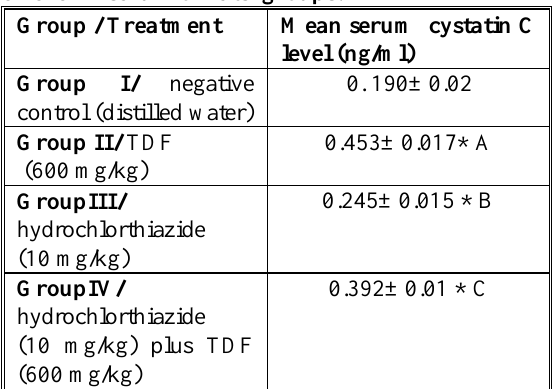
Table 1. Effect of different treatments on